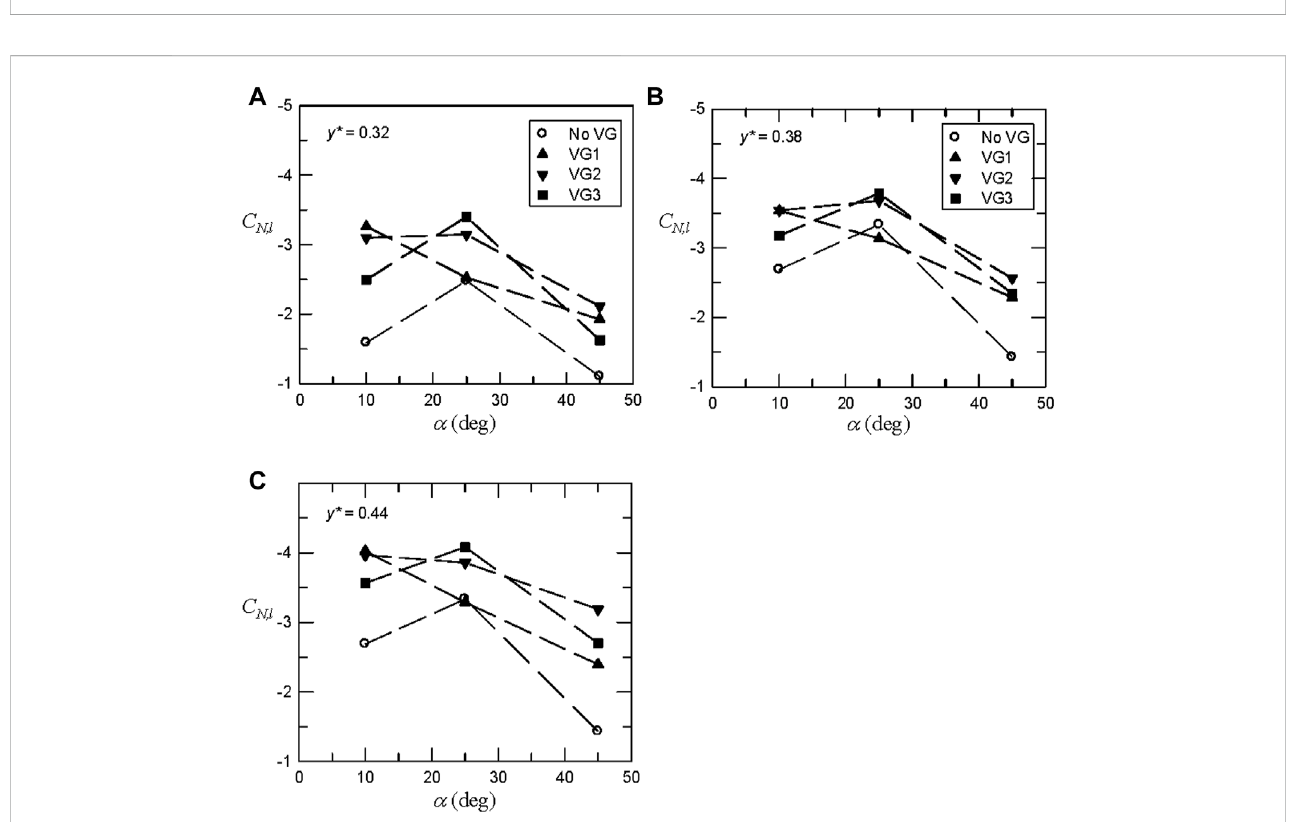
FIGURE 8 The strength of the low-pressure region on the upper surface at different spanwise locations: (A – C) Spanwise locations at y * = 0.32, 0.38, and 0.44,